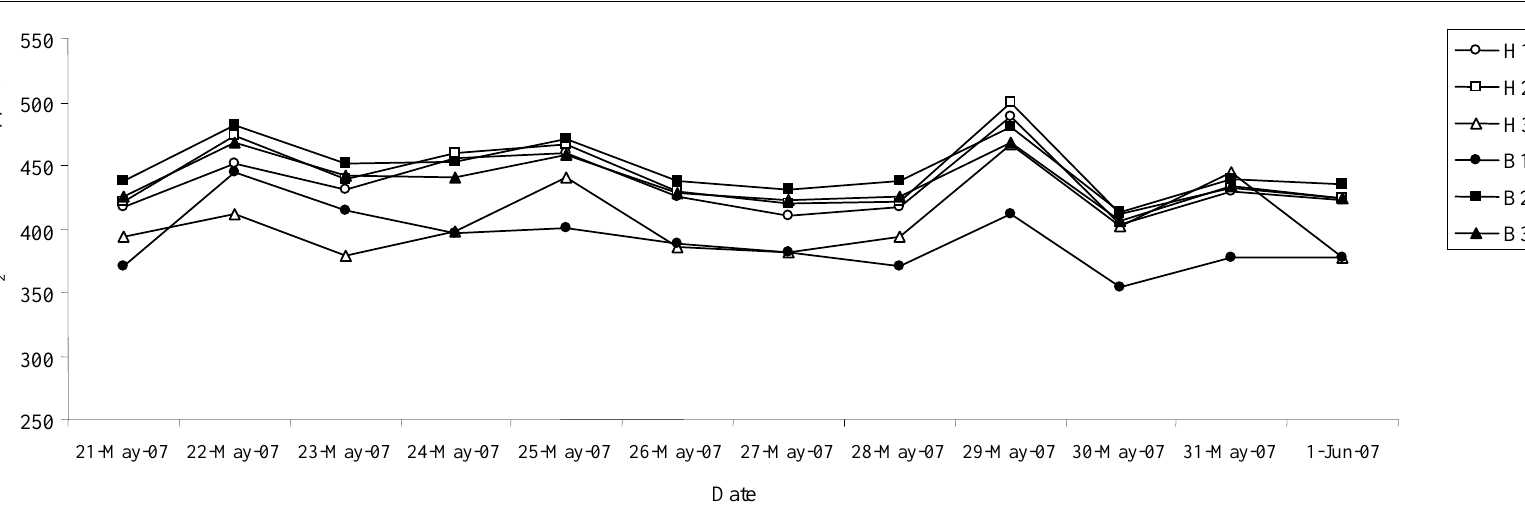
levels (ppm) measured in side-by-side analysis with 6 sensor units for the entire study (Results are 2